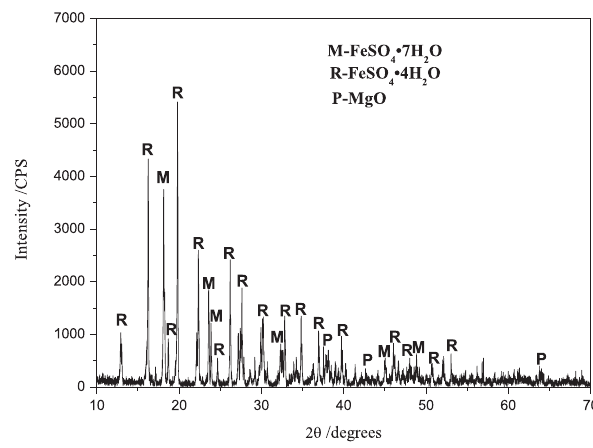
Fig. 1: The XRD profile of the raw material ferrous